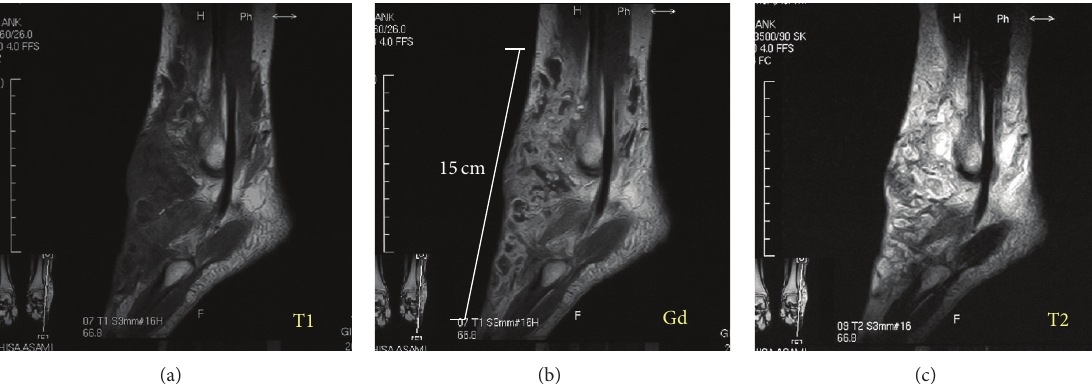
Figure 1: MRI showing an ill-defined heterogeneous soft tissue mass. T1 weighted image (a) shows the lobular low signal area in ill-defined border from iso- to low signal lesion, where it is enhanced by gadolinium (b) on the anterolateral part of the ankle. T2 weighted image (c) shows ill-defined delineated mixed high signal and low signal lesion.